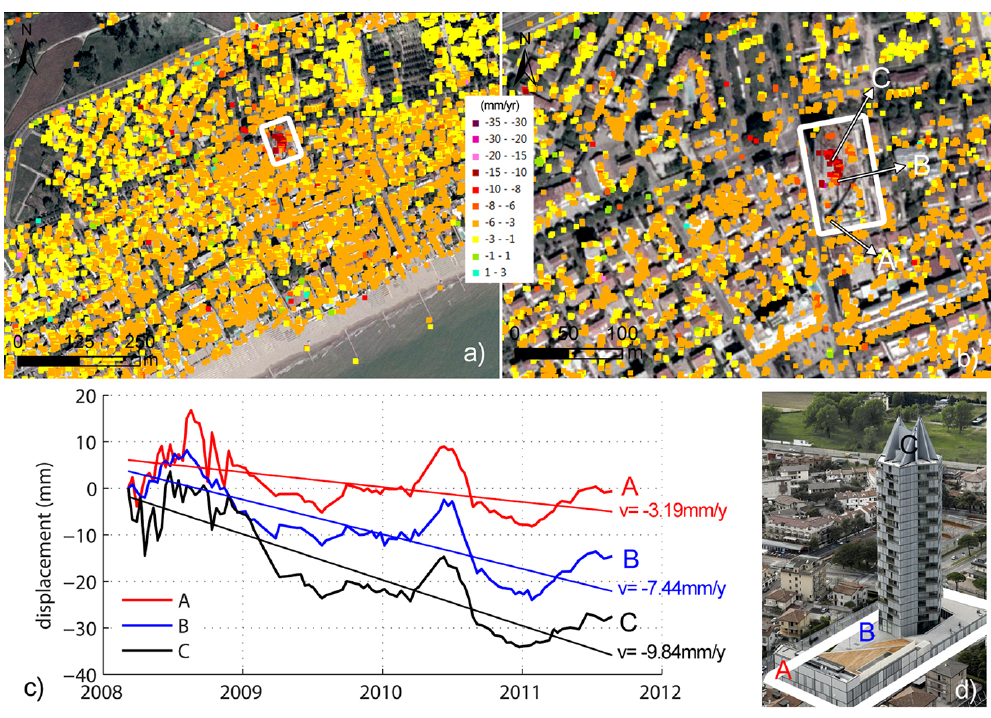
Figure 6. (a, b) Mean displacement rates between March 2008 and August 2011 from TerraSAR-X interferometry at Jesolo. The image background is an aerophotograph acquired in 2007. Negative values indicate settlement, positive mean uplift. (c) Displacement history in the satellite line-of-sight direction for three scatterers (A, B, C). (d) Photograph of Aquileia Tower, Jesolo, which is the cause of the largest movements. See location 4a in Fig.